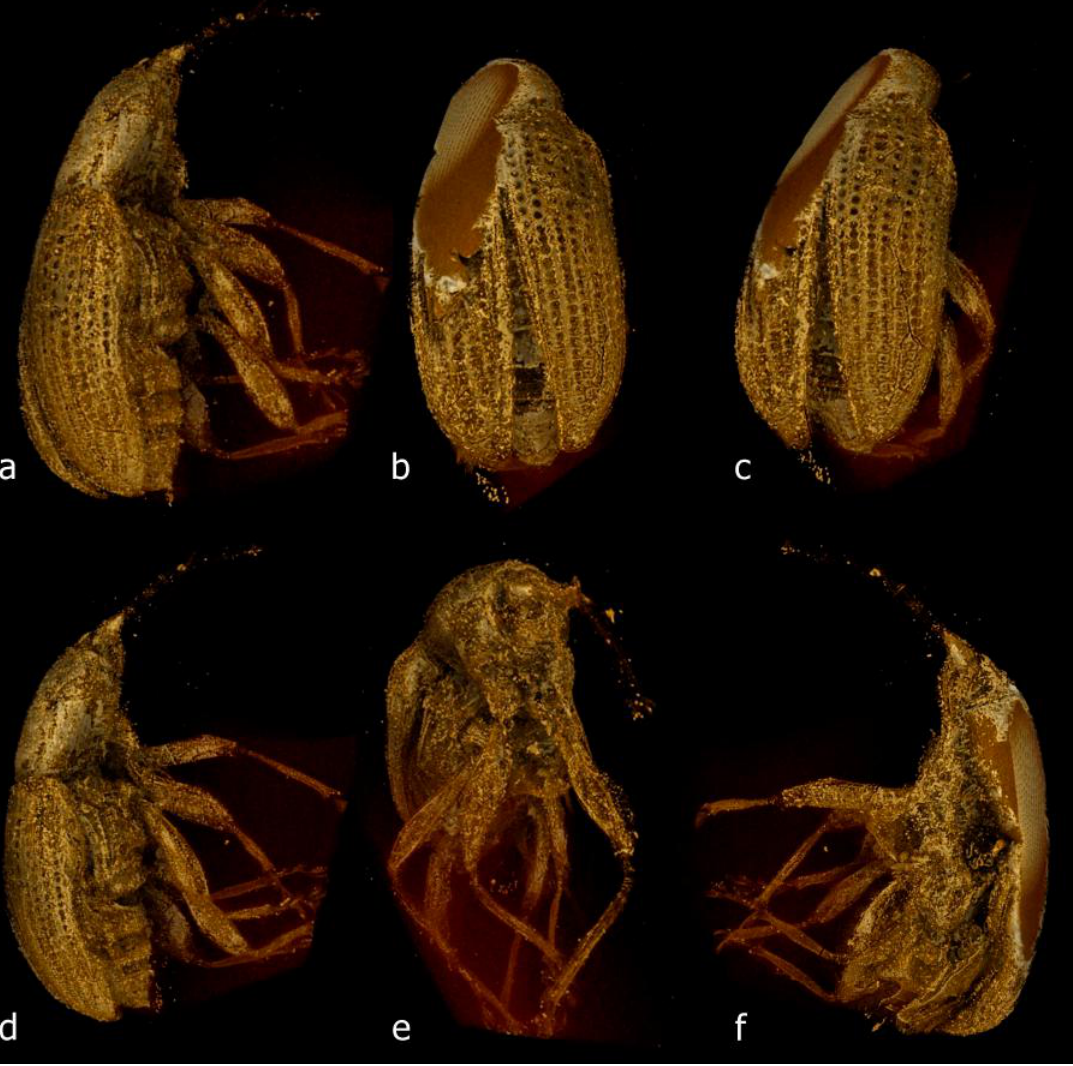
Figure 42. Opeatorhynchus comans sp. n., holotype. Habitus images extracted from a micro-CT scanning reconstruction (see also Video S4). Right lateral oblique ( a ); dorsal ( b ); right dorsolateral ( c ); right lateral ( d ); frontoventral ( e ); left lateral ( f ).